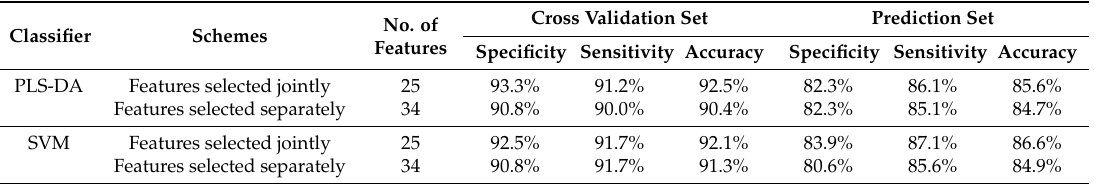
Table 2. Classification results of PLS-DA and SVM models distinguishing between bruised and healthy samples based on the fusion of push broom based and LCTF based HSI jointly at feature level.